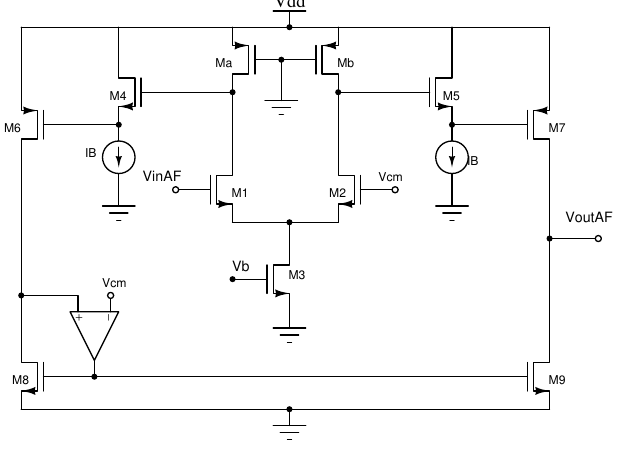
Figure 4. Non-linear activation function circuit.